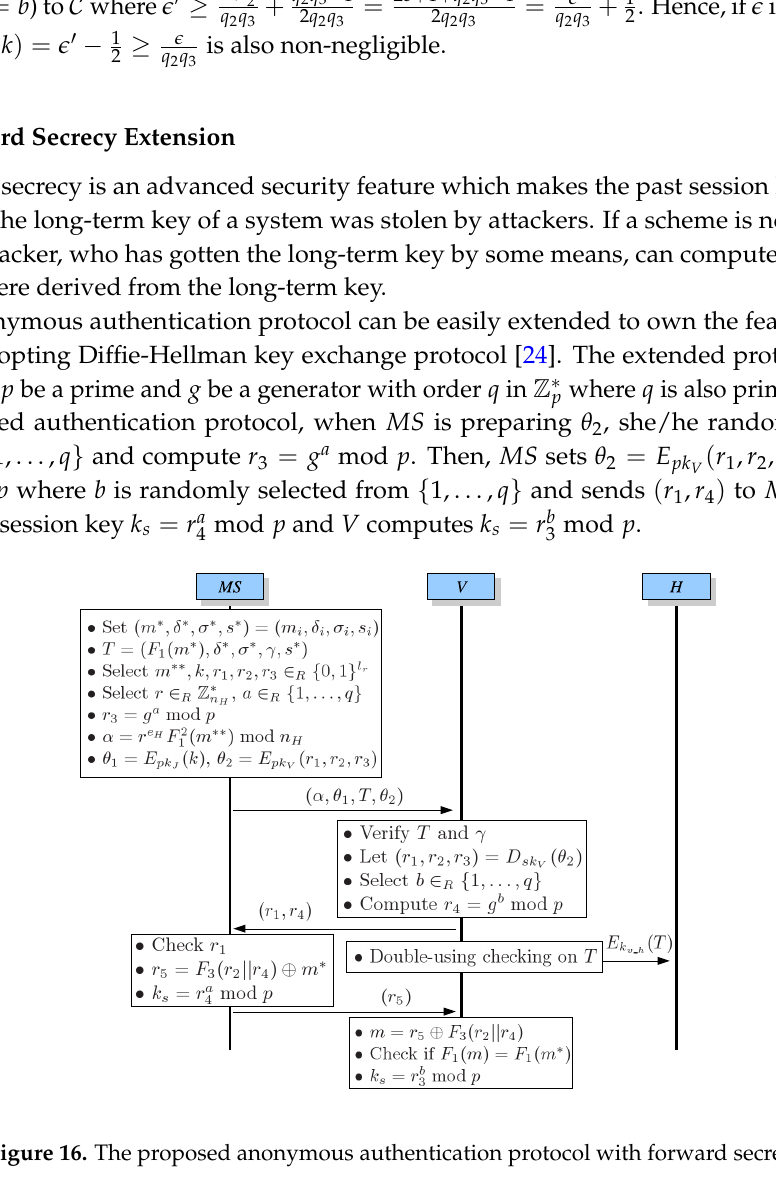
Figure 16. The proposed anonymous authentication protocol with forward